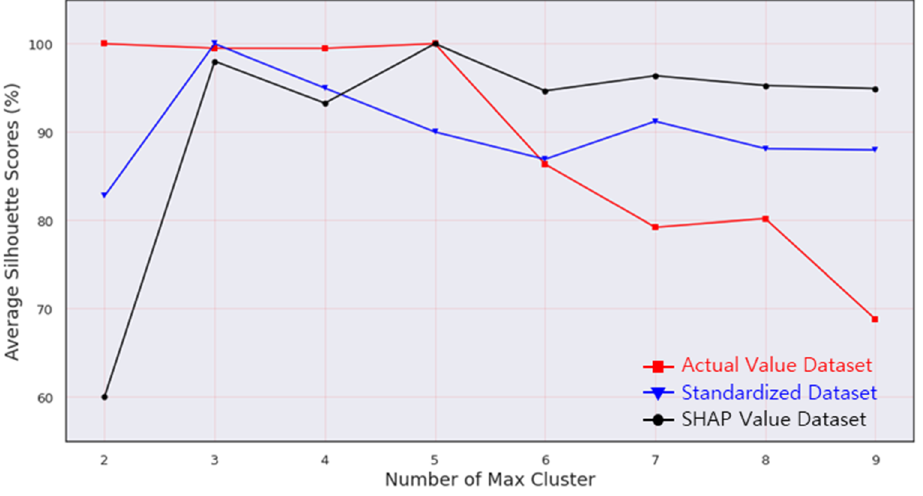
Figure 13. Percentage average silhouette score over clusters.